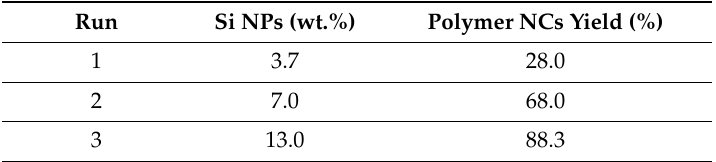
Table 2. Amount of Si NPs used in the experimental and final yield of poly(4,4 (cid:48) -cyclohexylidene bisphenol oxalate)/Si nanocomposites (NCs). Run Si NPs